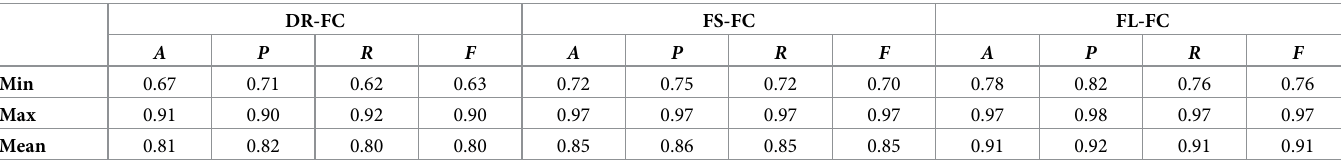
The table header A, P. R, and F are the shorthand of Accuracy, Precision, Recall, and F1-Score, respectively.